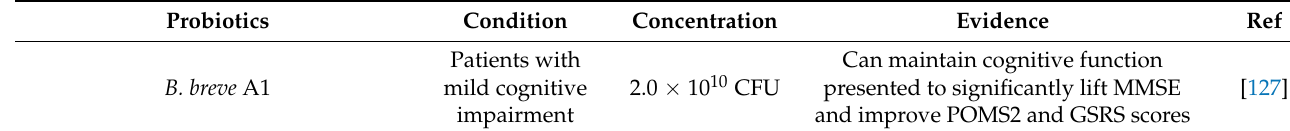
Table 5. Probiotics speculated to exhibit anti-Alzheimer